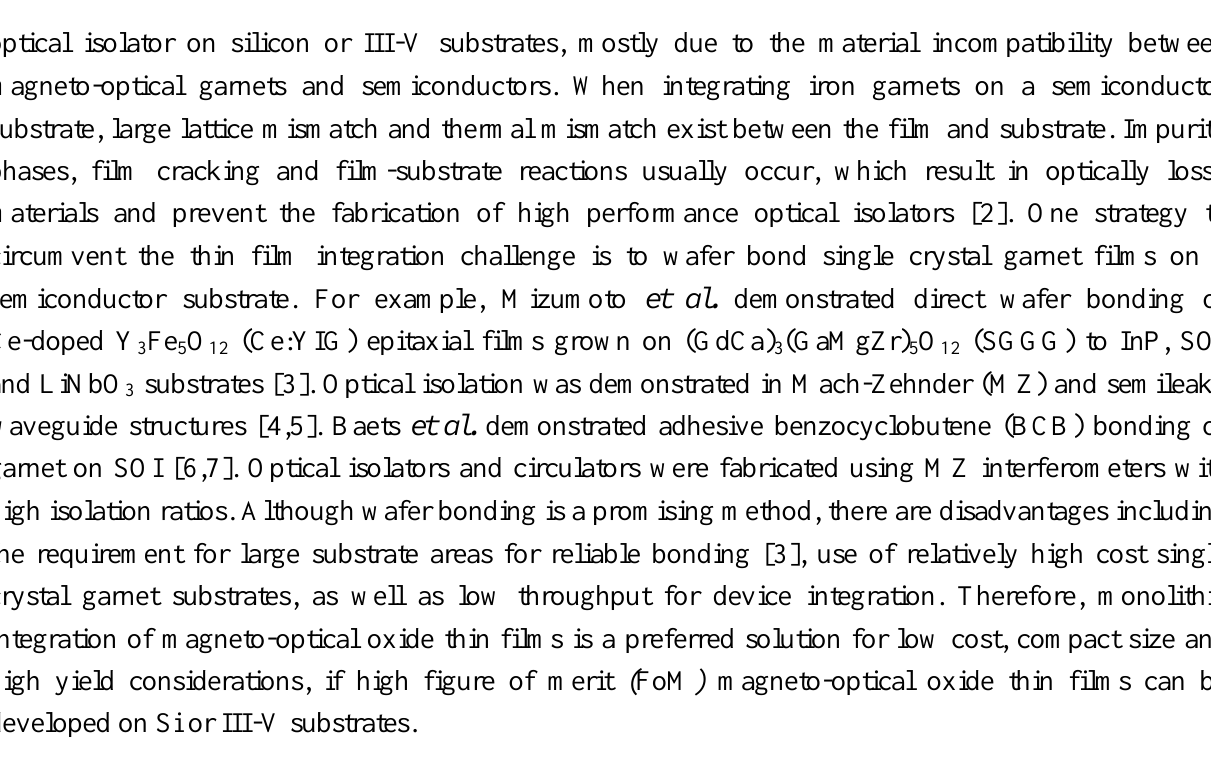
Figure 1. Sketch of a bulk optical isolator operating using the magneto-optical Faraday effect. The Faraday rotator is typically made from a Bi-substituted yttrium iron garnet (BiYIG)